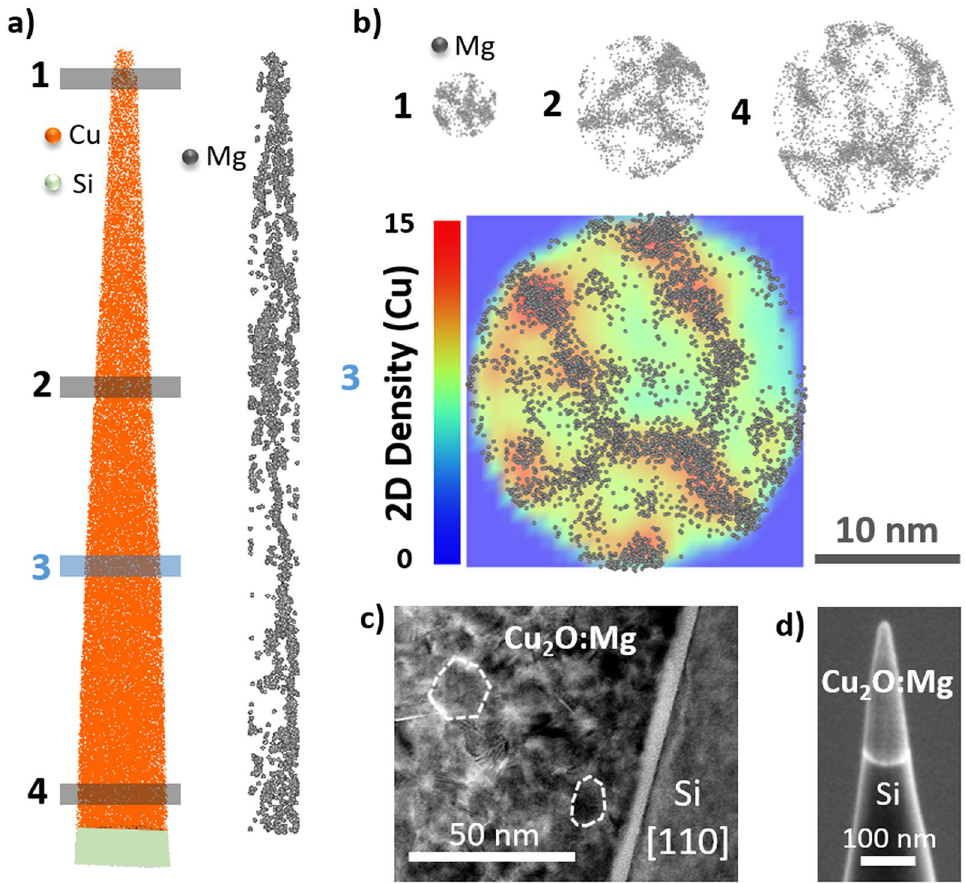
Figure 2. 3D atomic map of the as-deposited Cu 2 O:Mg film for which the tip shape shown in ( d ) was used to guide the tomographic reconstruction. ( a ) 3D atomic map of Cu and Si atoms is presented by orange and light green dots, respectively (left-hand side) and distribution of Mg in a 1 nm thick slice parallel to the APT specimen axis is shown, presenting a cross-sectional view of the film in dark grey dots (right-hand side). ( b ) 10 nm thick slices taken at different positions from top to bottom (number 1–4) represent a planar view of the film. In 1, 2 and 4 the 2D Mg ion maps are shown and in 3 this is superimposed with the Cu ion 2D density color map. ( c ) TEM micrograph of Cu 2 O:Mg thin film cross-section deposited on silicon and ( d ) SEM micrograph of the Cu 2 O:Mg specimen before APT